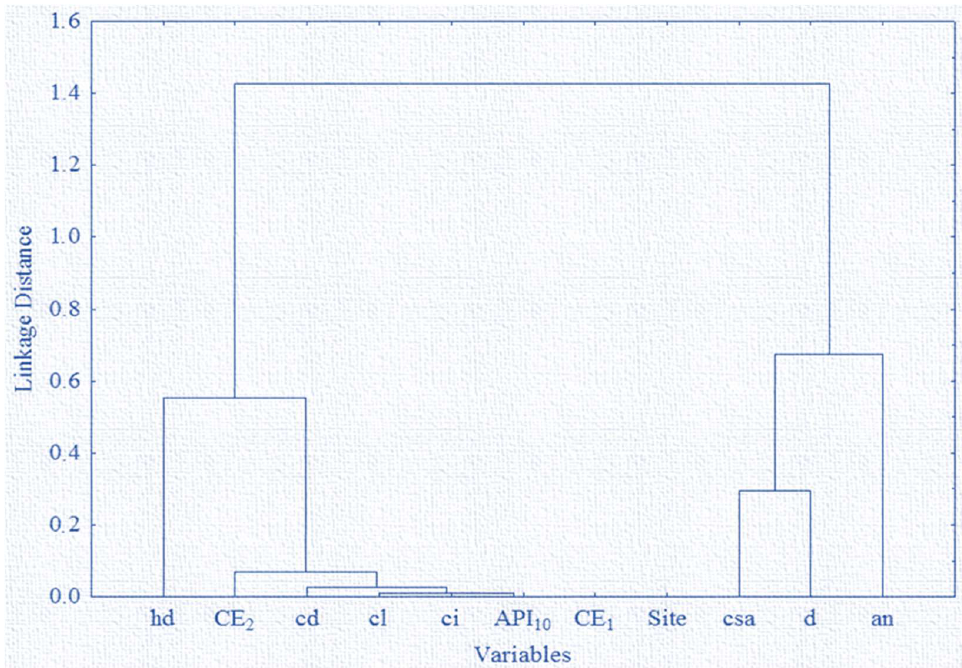
Figure 4. Dendrogram for dendrometric and morphometric grouping and related to male strobili production, which: cl = crown length; hd = degree of slenderness; CE = crown efficiency; API 10 = annual periodic increment in diameter; ci = coverage index; csa = crown surface area; cd = crown diameter; d = diameter at breast height; an = to male strobili number.